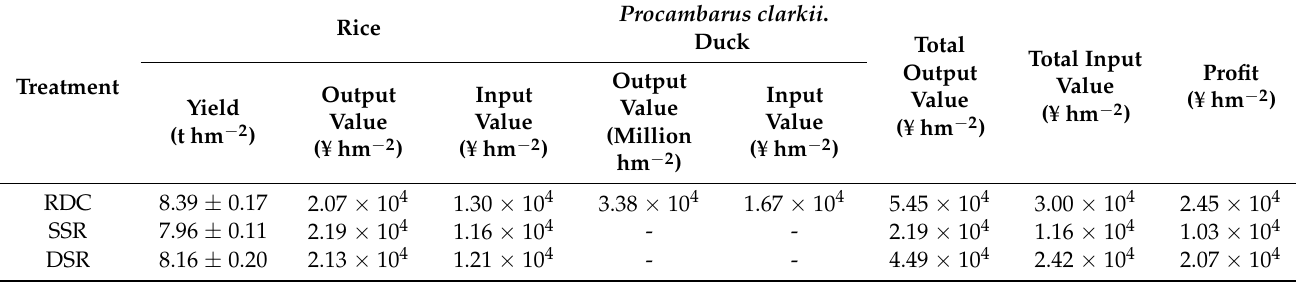
Table 3. Effects of different systems on the annual yield and economic benefit of paddy fields. Rice